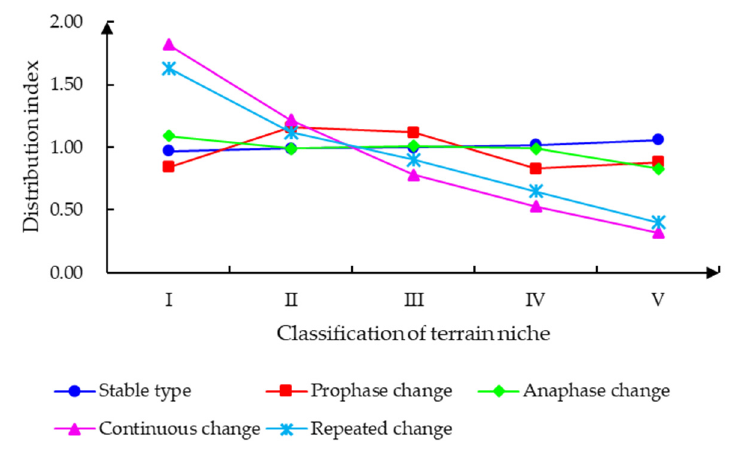
Figure 5. DI of terrain niche gradient for land-use structure changes.